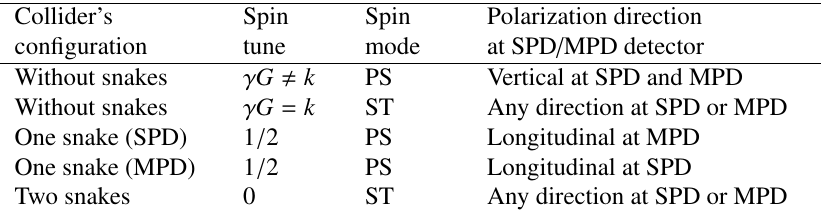
Figure 1. Possible operating regimes with polarized ions: a) the NICA collider without snakes, b) the NICA collider with one snake, c) the NICA collider with two snakes Table 1. Polarization in the SPD and MPD detectors in PS and ST